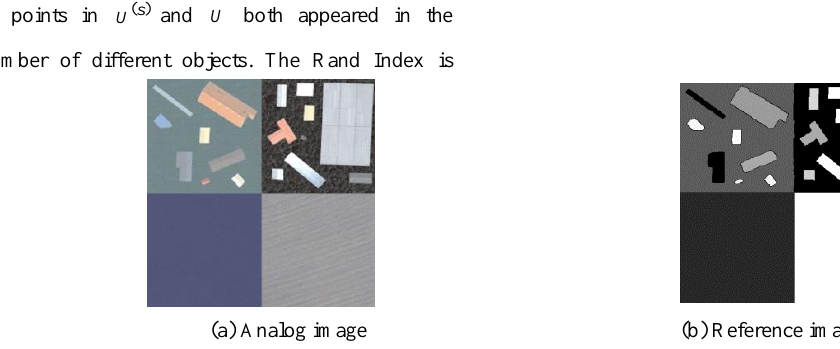
Figure 3. Analog image and reference